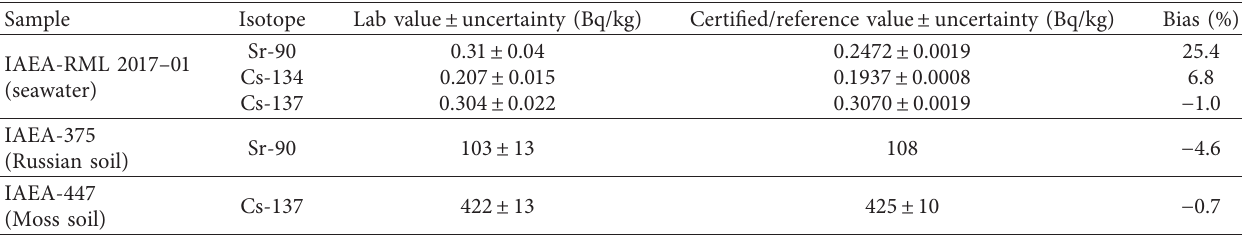
Table 4: Results of reference materials for QC of soil and seawater